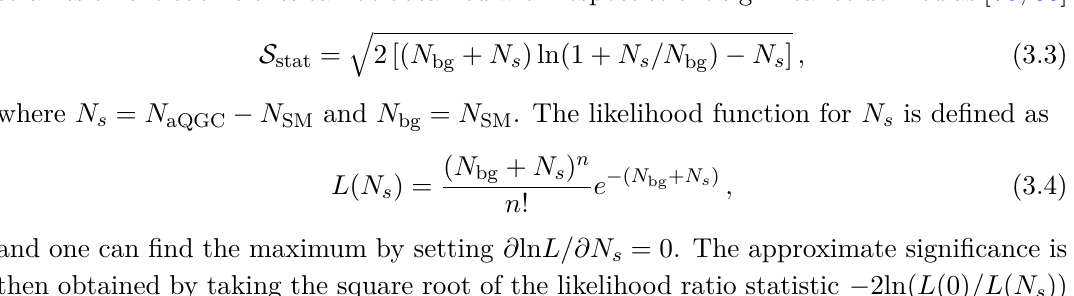
Figure 6 . The calculated and fitted σ ac (row 2), 14 TeV (row 3) and 30 TeV (row